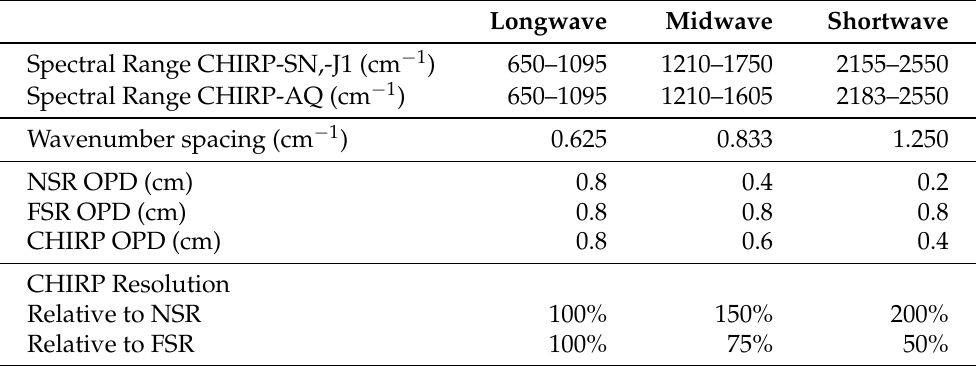
Table 1. CHIRP bands and their spectral resolution relative to CrIS normal spectral resolution (NSR) and high spectral resolution radiances (FSR), with associated maximum optical path differ- ences